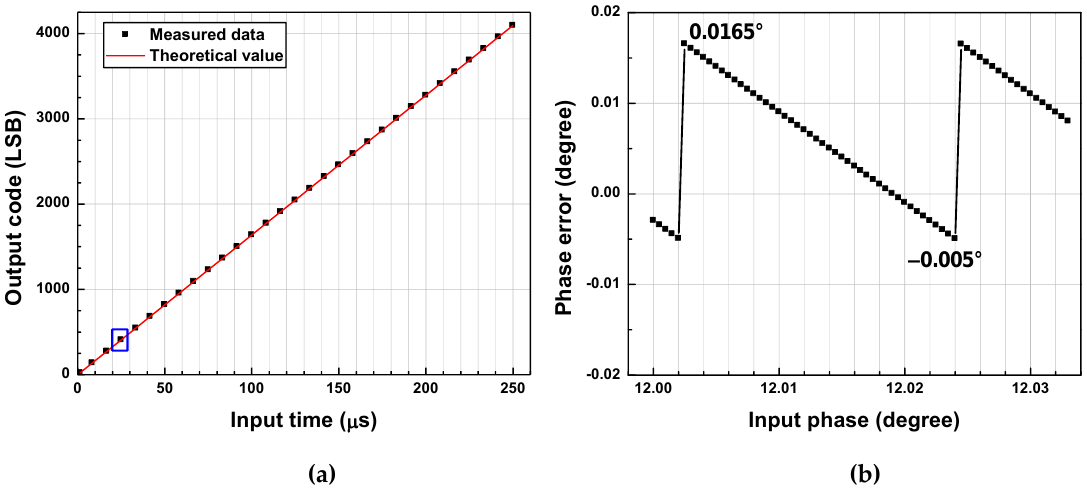
Figure 11. (a) Measured input-output characteristic of TDC, and (b) phase errors for f in = 1 kHz.